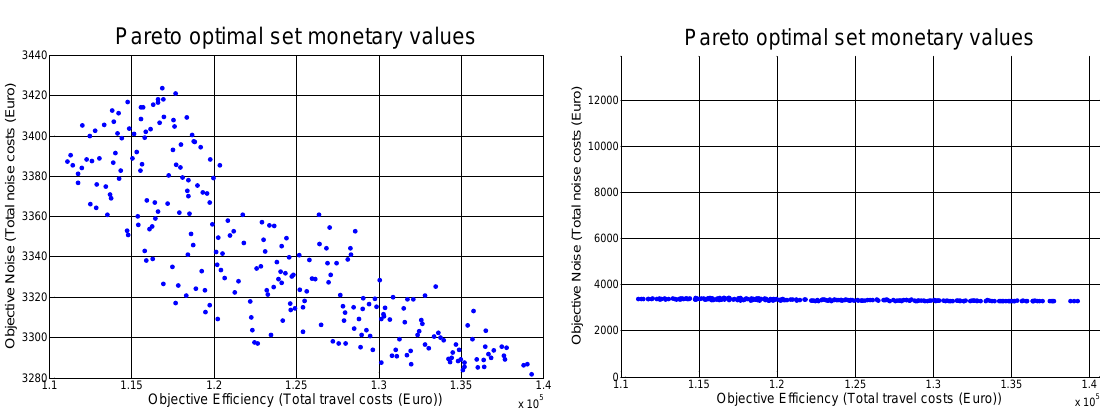
Figure 3. Pareto optimal sets in which externalities are